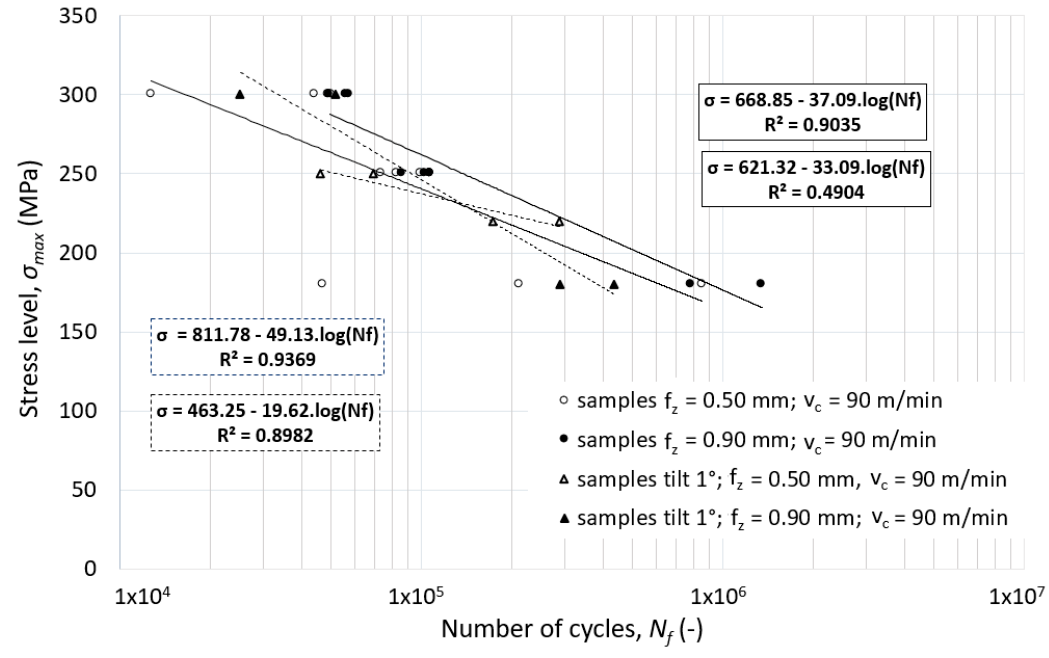
Figure 19. The effect of the tool inclination on the fatigue life of alloy 7475-T7351—flat un-notched specimen.